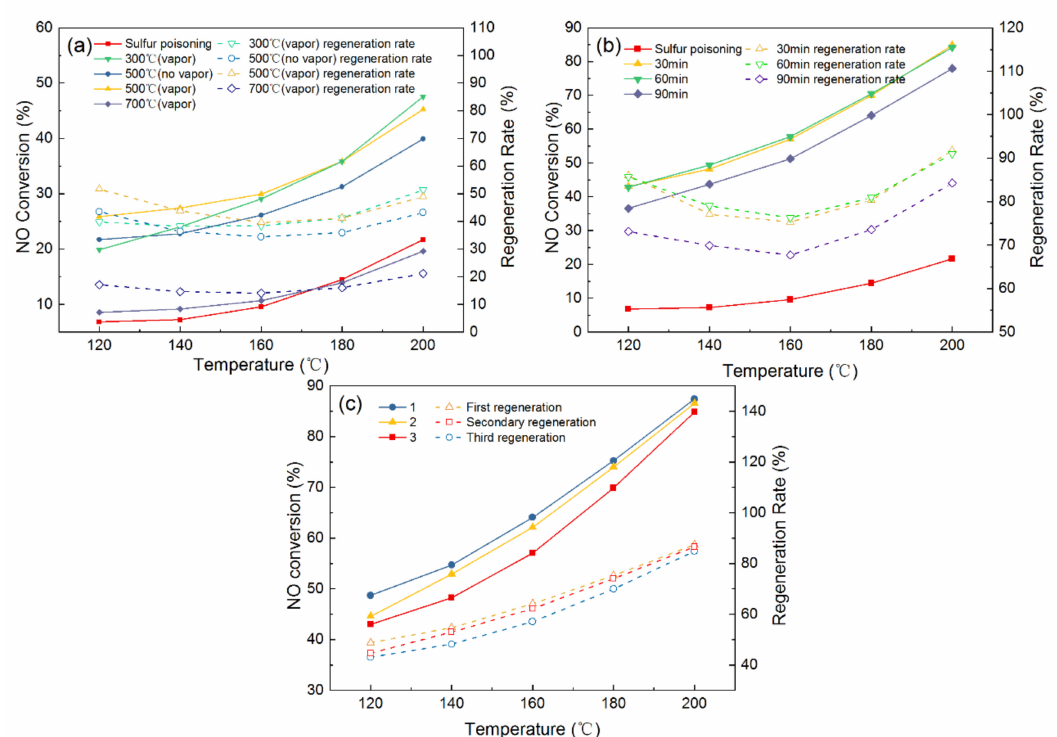
Figure 3. Catalyst activity and regeneration rate after ( a ) thermal regeneration at different temperatures, ( b ) regeneration at various washing times, and ( c ) regeneration